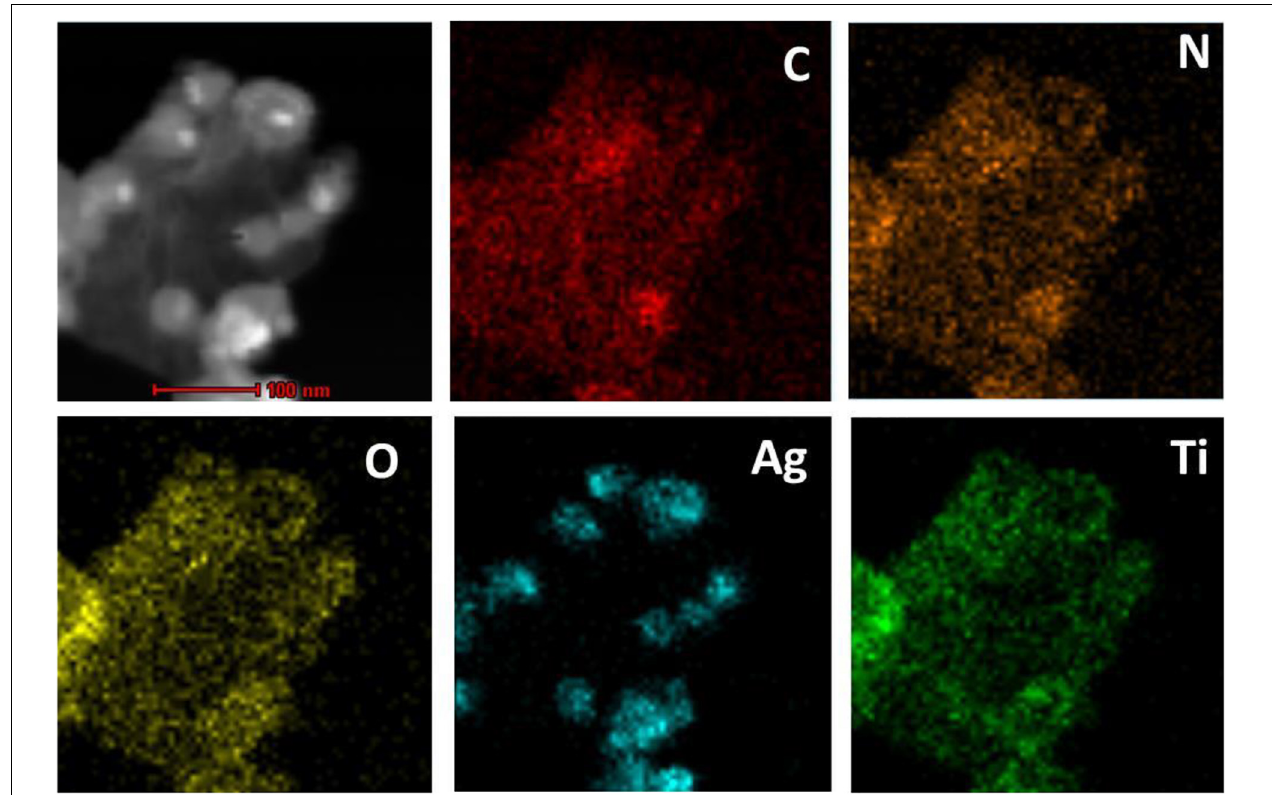
FIGURE 2 | Corresponding elemental mapping images of C, N, O, Ag, and